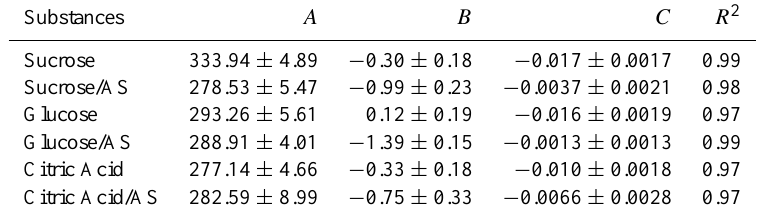
Fig. A1. Spectral subtractions corresponding to experiments shown in Fig. 1 demonstrate growth of the Raman O-H stretching peak (3100– 3600cm − 1 ) associated with liquid water uptake during crystalline (left) and amorphous (right) deliquescence experiments with citric acid. Onset of water uptake is observed in highlighted spectra (blue and red), which correspond to onset RHs of 76.2% for crystalline deliquescence and 30.9% for amorphous deliquescence. Table A1. Fit parameters for T g (RH) lines for all investigated aqueous organic glasses and mixtures. Y = A + BX + CX 2 , where X is humidity from 0–100% and Y is temperature in Kelvin. Parameters are listed along with uncertainties at the one standard deviation